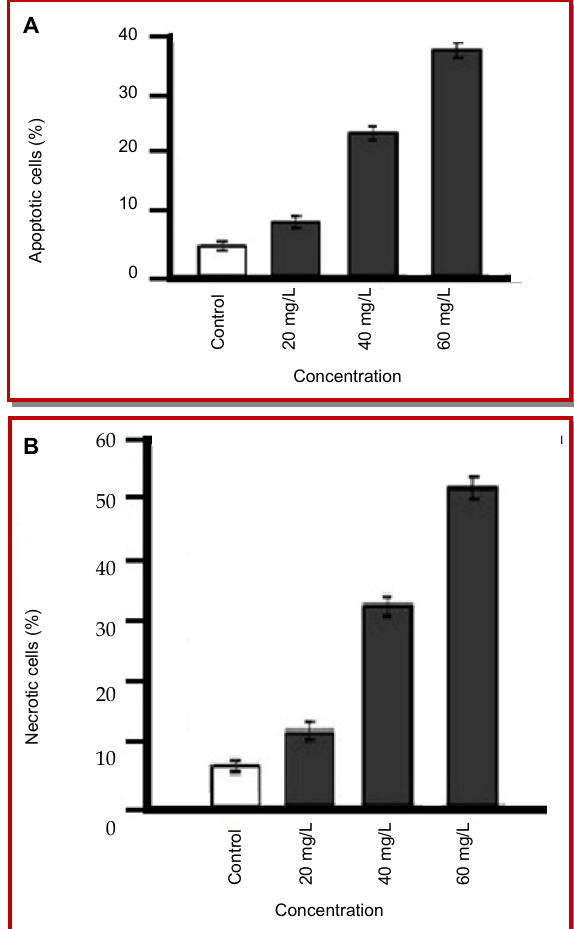
Figure 5: Schizophyllan effects on the apoptosis of CNS-1